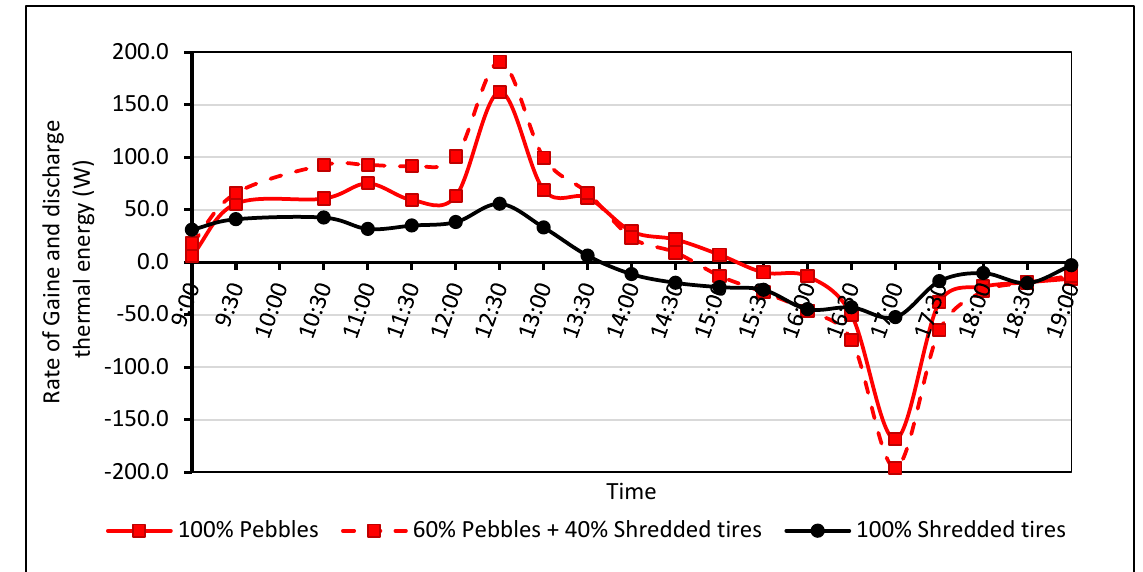
Figure 9. Comparison of thermal storage capacity of pure pebbles and a mixture of 60% pebbles + 40% shredded tires.